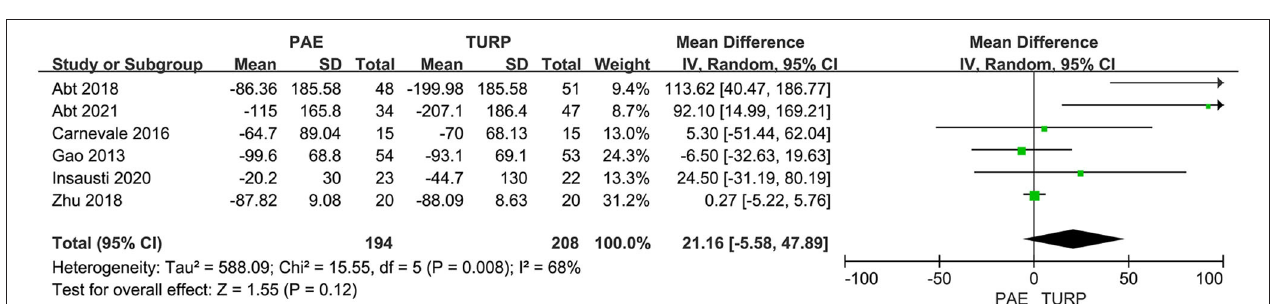
FIGURE 6 | Forest plot for PVR. PVR, post void residual.